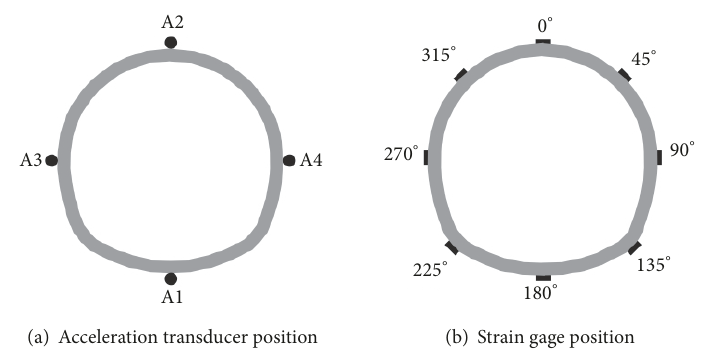
Figure 5: Monitor points of tunnel (unit: